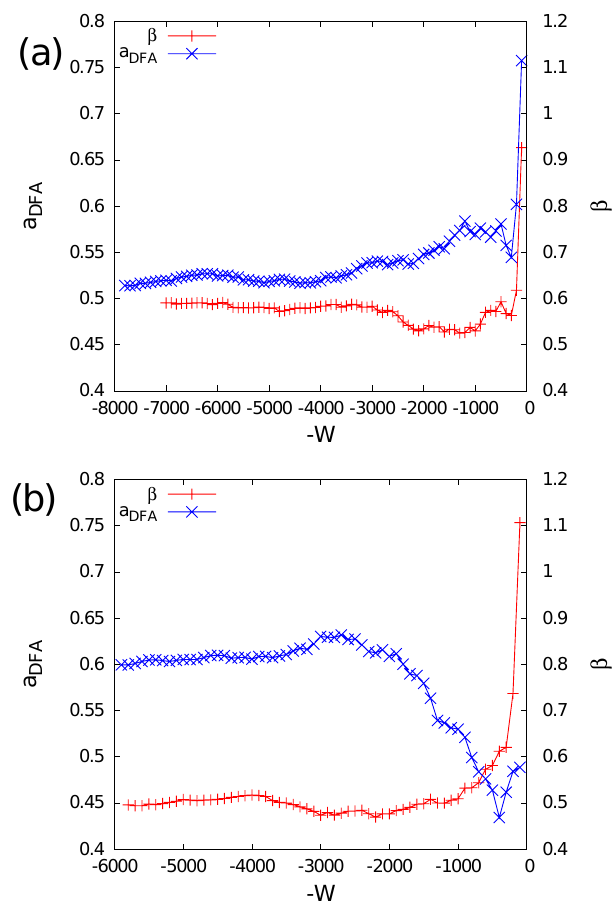
Fig. 4. (color online) The exponent a DFA (blue, left scale) and the variability β (red, right scale) versus the number of the avalanches preceding a large avalanche, Q k = 40325 for (a) and Q k = 31145 for (b) , that corresponds to W = 0 for the OFC model ( K = 1, L =